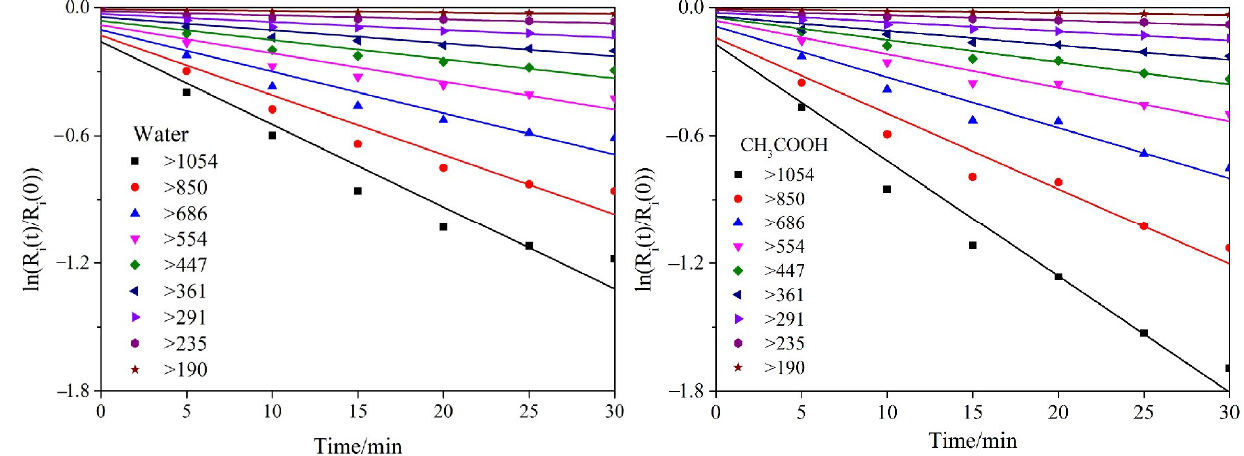
Figure 9. The fi rst Kapur functions calculated by linear fi tt ing of cumulative fraction residual of Figure 9. The first Kapur functions calculated by linear fitting of cumulative fraction residual of particles ground in water and a CH 3 COOH solution. particles ground in water and a CH 3 COOH